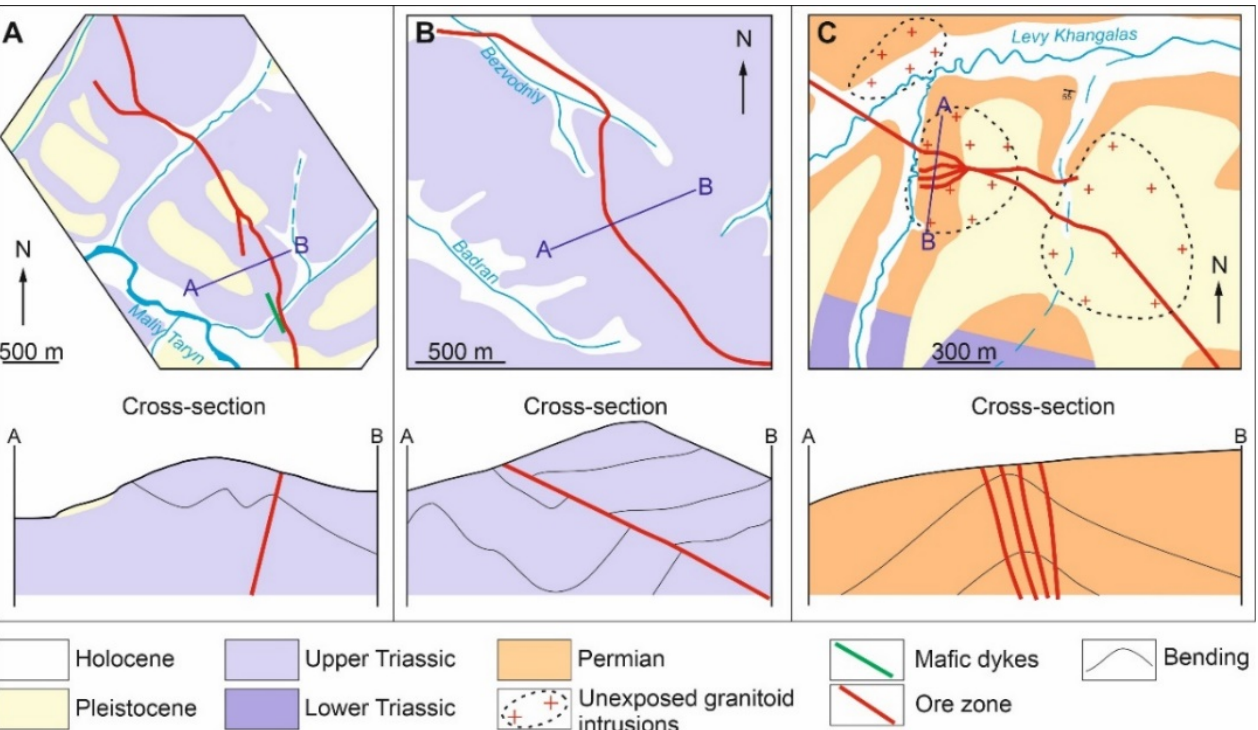
Figure 2. Geologic map and simplified cross ‐ sections of the sediment ‐ hosted OGDs, central YKMB: ( A ) Malo–Taryn; ( B ) Badran; ( C ) Khangalas.